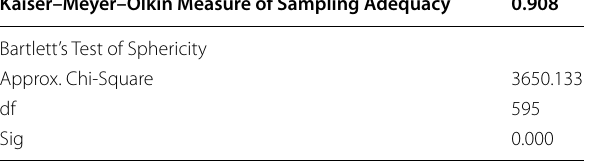
Table 5 KMO and Bartlett’s